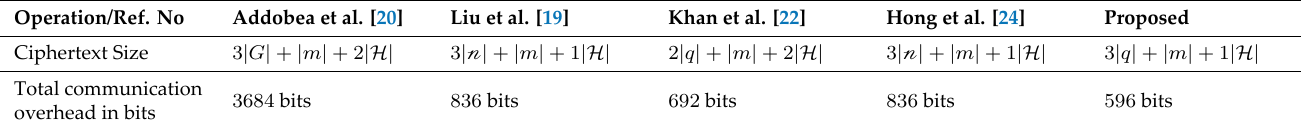
Table 8. Efficiency analysis of the communication